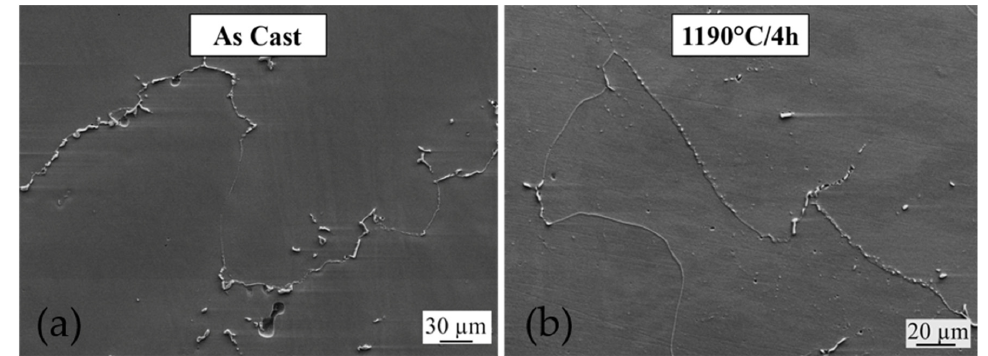
Figure 3. Scanning electron microscopy (SEM) images showing homogenization e ff ect along grain boundaries ( a ) as cast and at ( b ) 1190 ◦ C / 4